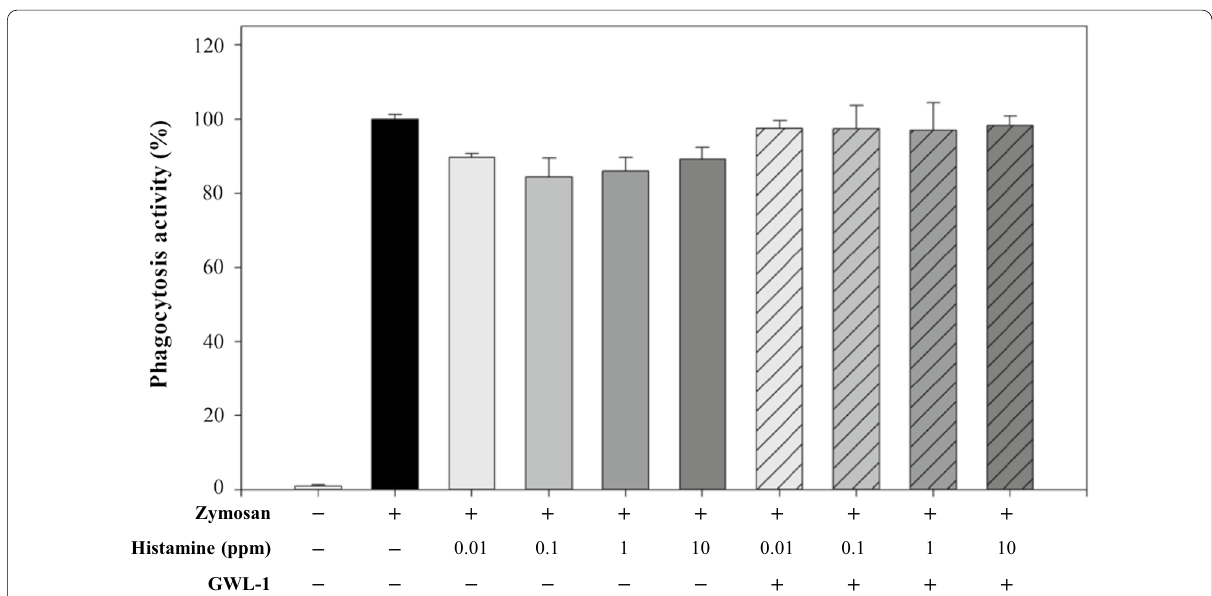
Fig. 5 Phagocytosis activity. Phagocytosis assays were performed to determine whether histamine affected RAW 264.7 cell’s phagocytosis, and to confirm the GWL‑1 cell’s histamine inhibitory ability indirectly. Histamine inhibited the phagocytosis of RAW cells, and histamine reacting with GWL‑1 did not inhibit phagocytosis. As a result of confirming this, GWL‑1 was found to capture